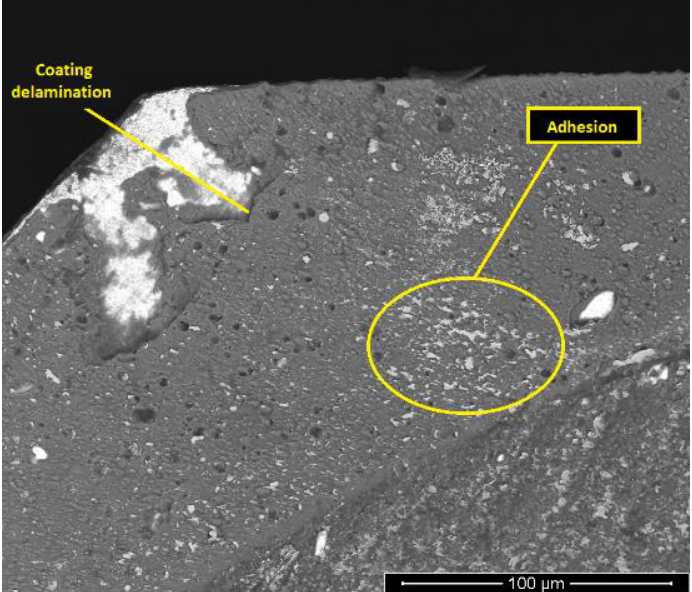
Figure 11. Coating delamination registered in the rake face of a T2L2F100 tool. At higher feed rates, primarily at a 125% feed rate, the amount of adhesive wear was lower than that registered at lower feed rate values. However, the tools presented abrasion marks and cracking, exhibiting high levels of wear as well. In Figure 12, the abrasive wear can be observed in a T2 tool, tested at a 125% feed rate. The coating was abraded, exposing the substrate. However, there was some coating delamination, especially in the tool’s rake face, possibly caused by adhesive wear, as shown in Figure 13.